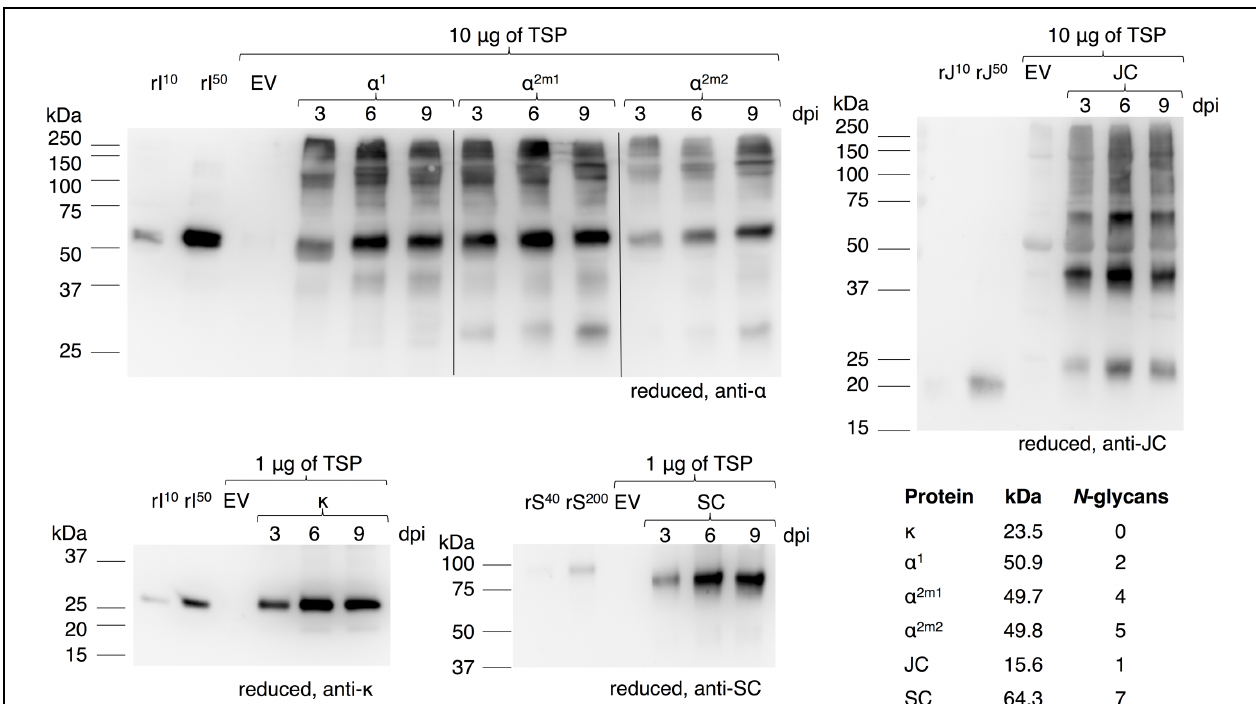
FIGURE 2 | Plant-based expression of individual genes required for sIgA assembly. Leaves were agro-infiltrated for the expression of alpha heavy chain 1 ( α 1 ), 2m1 ( α 2 m 1 ), 2m2 ( α 2m2 ), kappa chain ( κ ), JC, or SC and harvested 3, 6, and 9 dpi. Total soluble protein (TSP) was extracted and separated by SDS-PAGE under reducing conditions followed by visualization on a western blot using protein specific antibodies as indicated. As controls 10 or 50 ng of recombinant IgA1 κ (rI 10 / 50 ), recombinant joining chain (rJ 10 / 50 ) or 40 or 200 ng purified sIgA (rS 40 / 200 , containing ∼ 10 or 50 ng SC) and an empty vector (EV) sample were used. The table states the expected protein size as calculated by the amino acid sequences of the mature protein and the expected number of N -glycans according to literature.